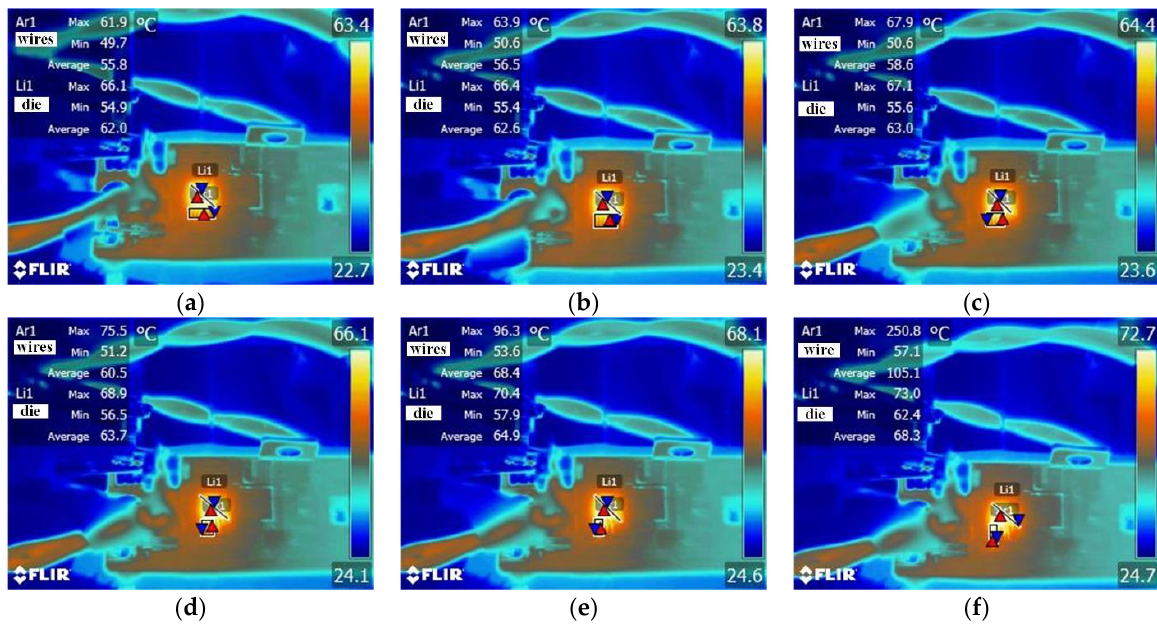
Figure 16. Thermal images of an IGBT device under 30 A with different wires removed ( a ) 0 wire ( b ) 1 wire ( c ) 2 wires ( d ) 3 wires ( e ) 4 wires ( f ) 5 wires.